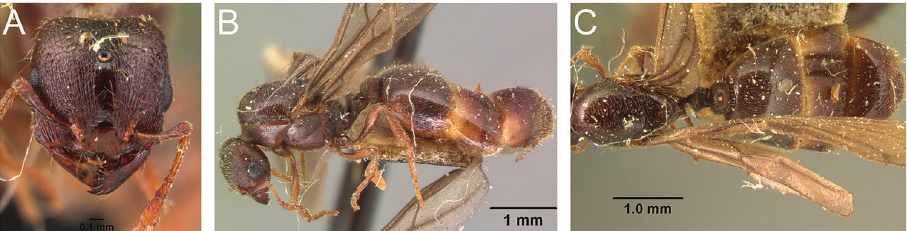
Figure 54. Carebara nosindambo -lectotype. Queen, CASENT0101937: A head in full-face view B body in profile view C body in dorsal